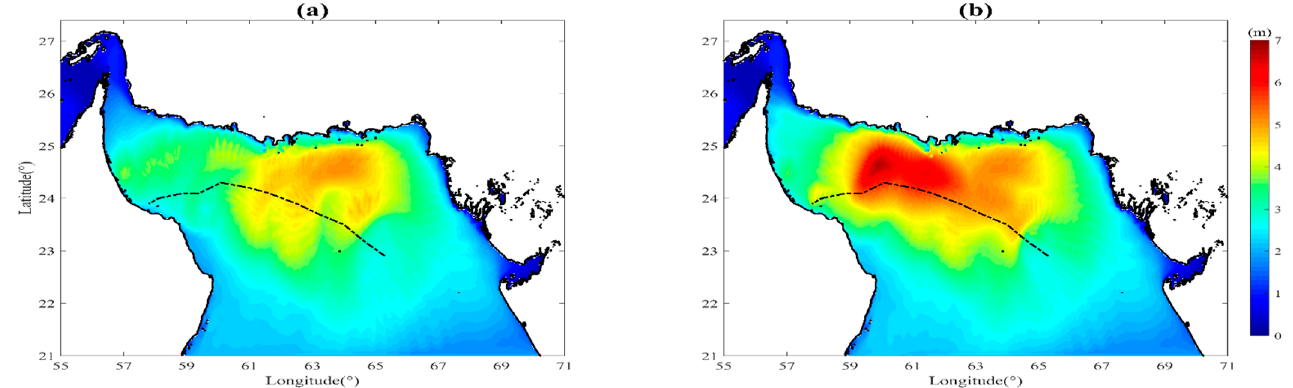
Figure 12. Predicted maximum significant wave heights by Janssen-Default using ( a ) ERA5 and ( b ) hybrid wind data. Black dash-dotted lines indicate the track of Cyclone Shaheen extracted from JTWC.